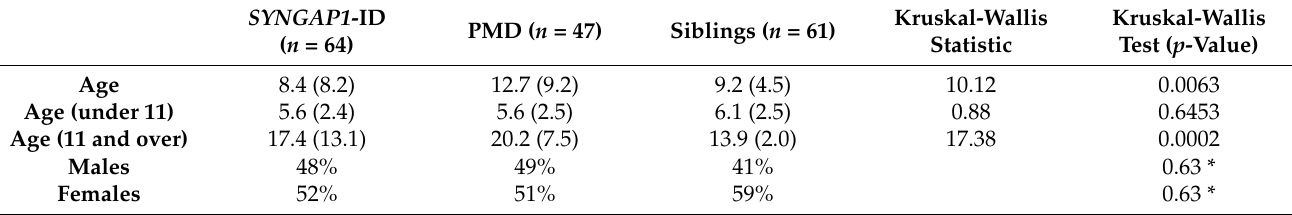
Table 1. Demographics, mean (standard